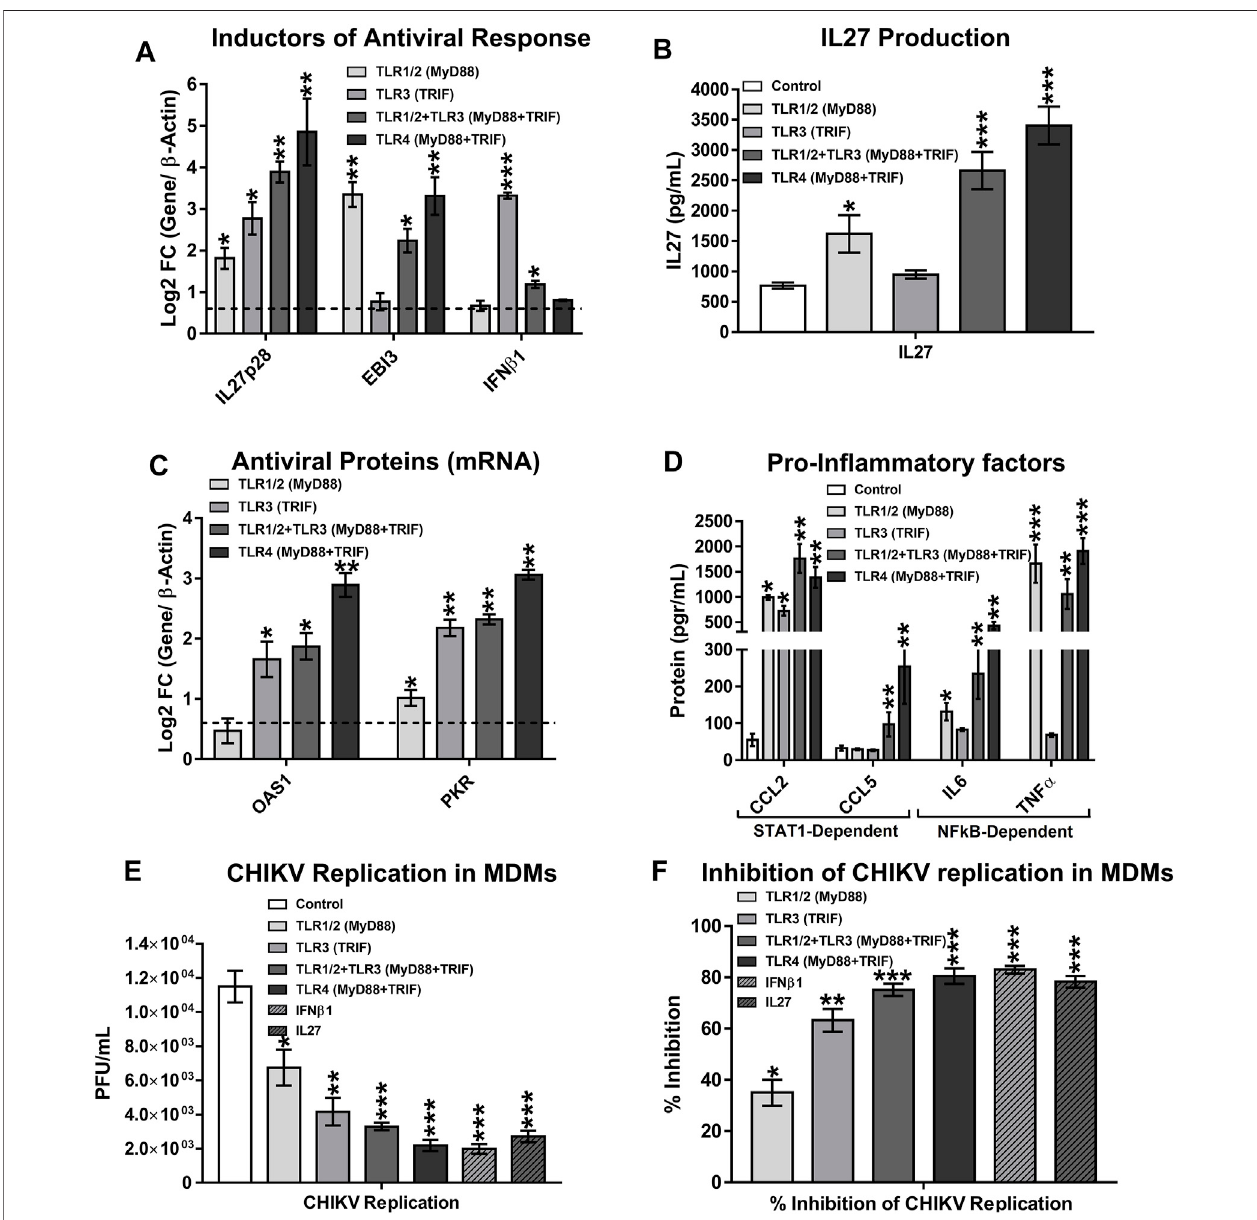
FIGURE 10 | Co-activation of TLR1/2-MyD88 and TLR3-TRIF, or activation of TLR4 triggers expression of IL27 which induces STAT1-dependent pro- in fl ammatoryandantiviralresponsetocontrolCHIKVreplicationinhumanMDMs.HumanMDMscultureswereleftunstimulatedorstimulatedwith50 ng/mlPam3CSK4 and/or 20 μ g/mlPoly(I:C),or50 ng/mlLPS.Celllysatesandculturesupernatants wereobtainedat 8 h,andRT-qPCRand ELISAwereperformed.mRNAexpressionof inductors of antiviral response (IL27 and IFN β 1) (A) . IL27 accumulation in culture supernatants of MDMs (B) . mRNA expression of AVPs (OAS1 and PKR) (C) . STAT1-dependent chemokines (CCL2 and CCL5) and NF- κ B-dependent cytokines (TNF α and IL6) accumulation in culture supernatants of MDMs (D) . Data are presentedasthemean±SEM.Kruskal – WallistestwithDunn ’ spost-testwasperformed.Signi fi cantresultsarede fi nedas p < 0.05(*), p < 0.01(**)and p < 0.002(***). n = 4. Human MDMs were pre-treated for 8 h with 50 ng/ml Pam3CSK4 and/or 20 μ g/ml Poly (I:C), or 50 ng/ml LPS, or 25 ng/ml of recombinant-human IFN β 1 or IL27. Next, MDMs cultures were infected with CHIKV at MOI 5. Culture supernatants were obtained at 24 hpi and viral titration was performed by plaque assay on Vero cells. CHIKV replication in MDMs (E) . Percentage of viral inhibition in MDMs (F) . Kruskal – Wallis test with Dunn ’ s post-test was performed. Signi fi cant results between unstimulated and pre-treated MDMs are de fi ned as p < 0.05 (*), p < 0.01 (**), and p < 0.002 (***). n = 4.